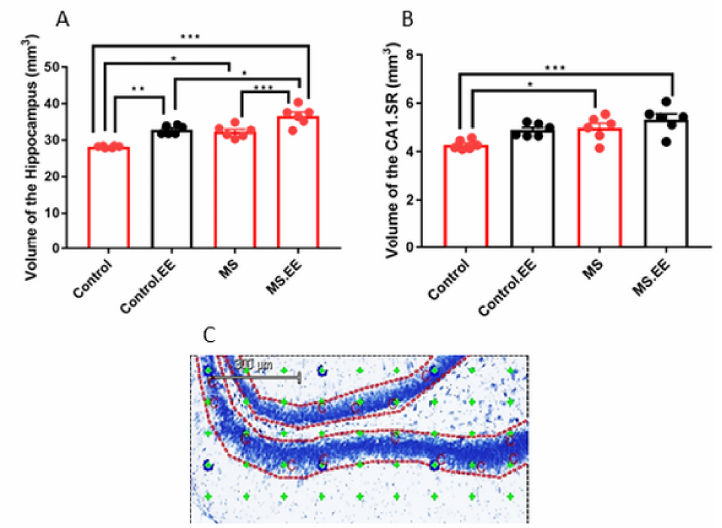
Figure 5. Effects of maternal separation and EE on the hippocampus ( A ) and CA1.SR volumes ( B ) * p < 0.05, ** p < 0.01, *** p < 0.001. Illustration of Cavalieri estimator using point counting to measure the volume of the GCL sub-region of hippocampus (objective lens 10 × ) ( C ). N = 6 in each group. MS: Maternal Separation, EE: Environmental